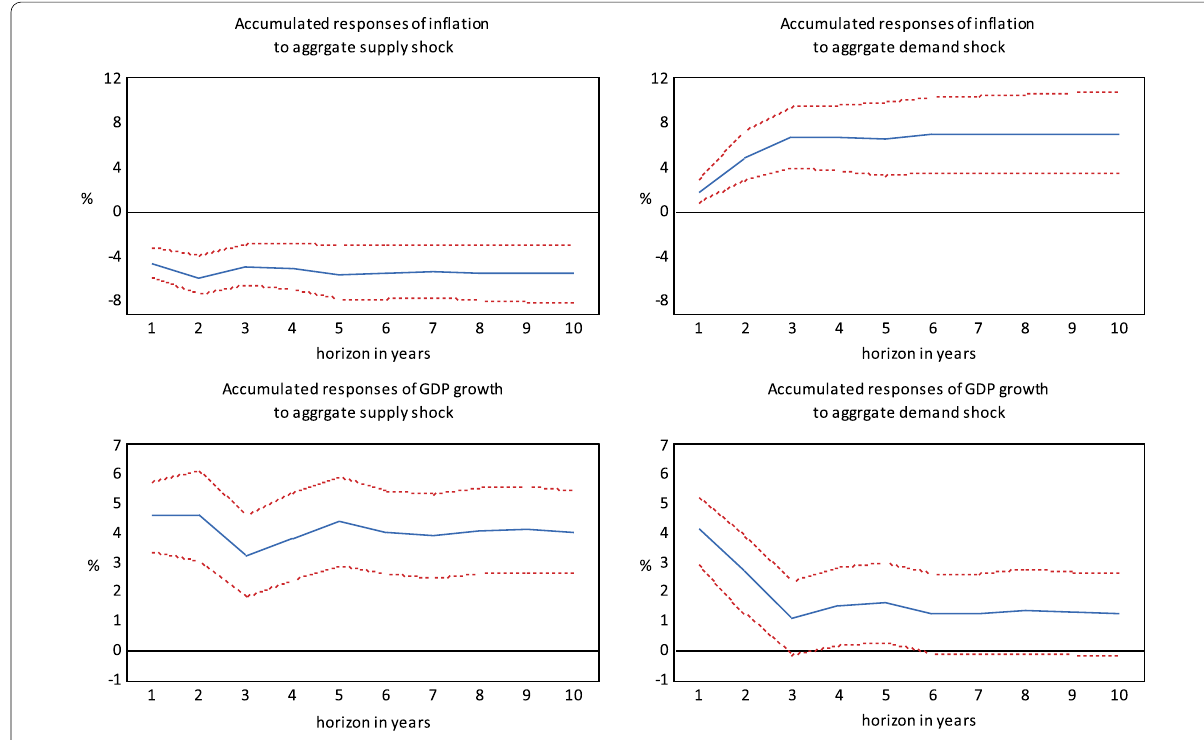
Fig. 3 Accumulated impulse responses to aggregate demand and supply shocks with 95% confidence